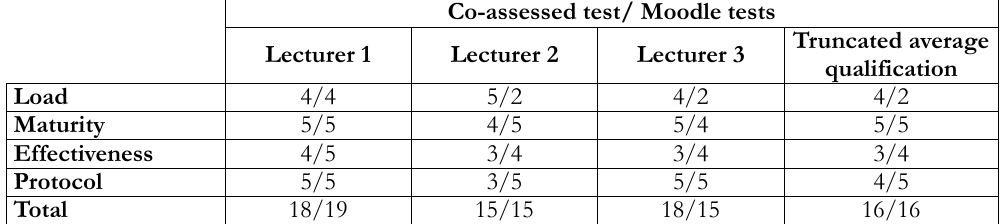
Table 2. The final mark through continuous